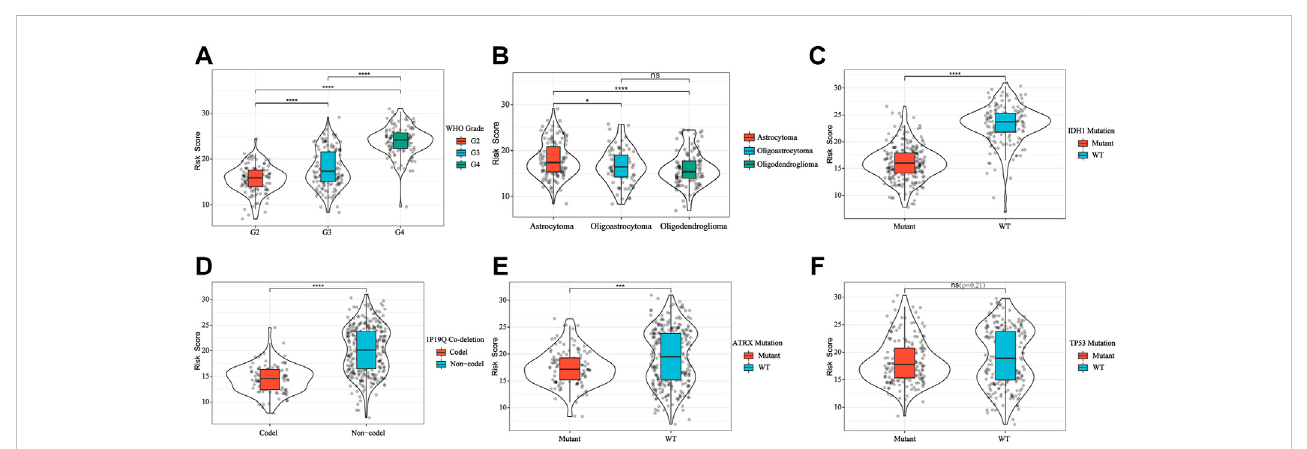
FIGURE 4 IFN- γ -associated gene scoring model was correlated with WHO Grade (A) , glioma subtype (B) , IDH1 (C) , 1P19Q co-deletion (D) , ATRX (E) and TP53 (F) . ** p < 0.01, **** p < 0